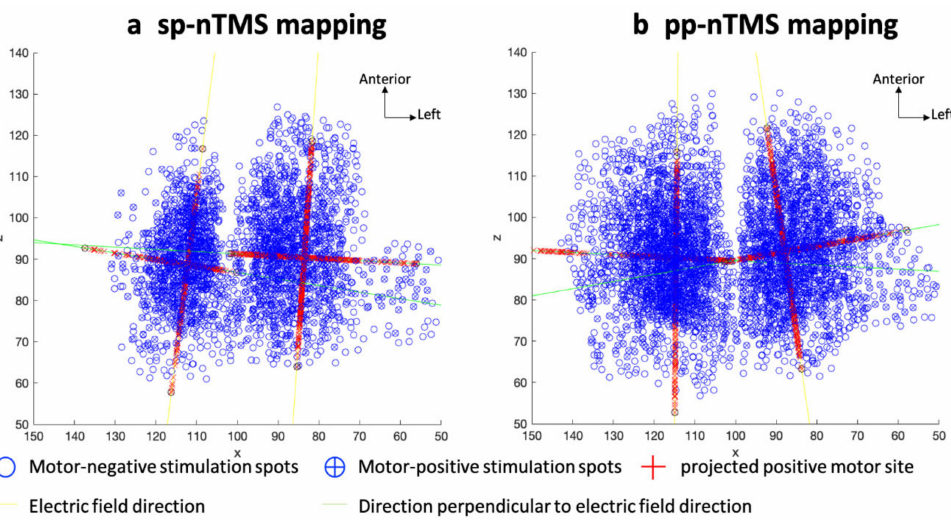
Figure 4. Aspect ratio. This map illustrates the aspect ratio for motor mapping of the lower extremity (lE) muscle representations by single-pulse navigated transcranial magnetic stimulation (sp-nTMS, ( a )) and paired-pulse nTMS (pp-nTMS, ( b )). Yellow lines represent the electric field direction in the weighted center of the map, green lines depict the direction perpendicular to the electric field. Motor-negative stimulation spots are shown as blue circles without crosses, and motor-positive stimulation spots are depicted as blue circles with crosses. The red crosses without circles represent the motor-positive stimulation spots projected onto the lines, and the red crosses with black circles show the projected motor-positive stimulation spots with the longest distance from each